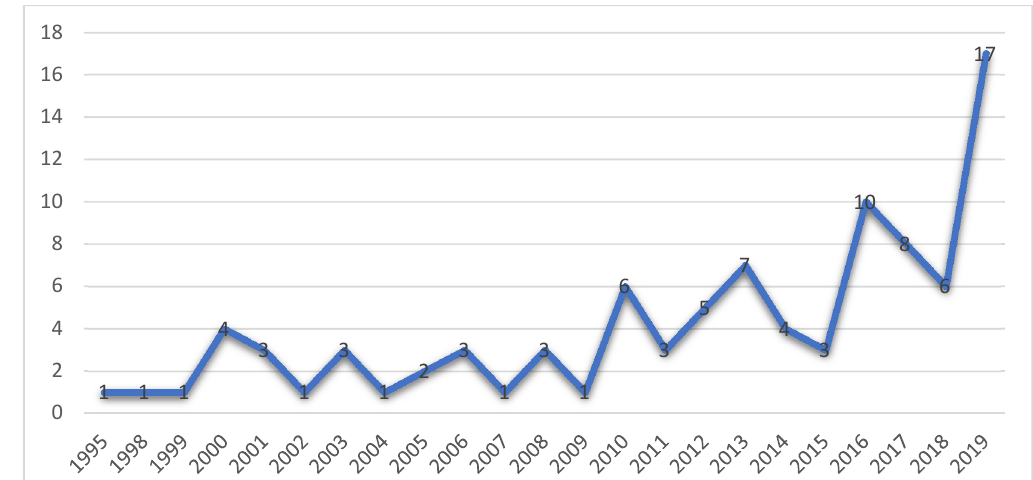
Figure 3. Frequency of publications (1995–2019).